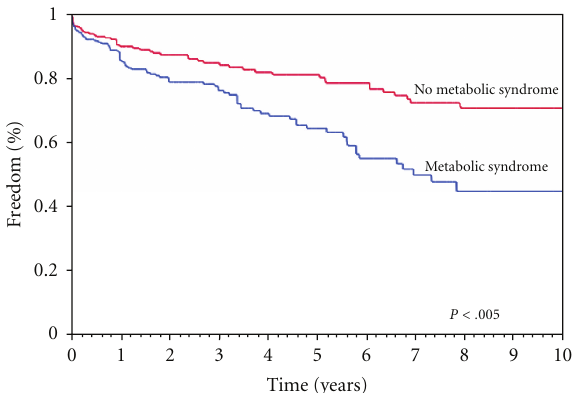
Figure 1: Kaplan-Meier analysis of freedom from renal-related morbidity (persistent increase in creatinine > 20% of baseline, progression to hemodialysis, death from renal-related causes) for the patients with and without MetS. Values are